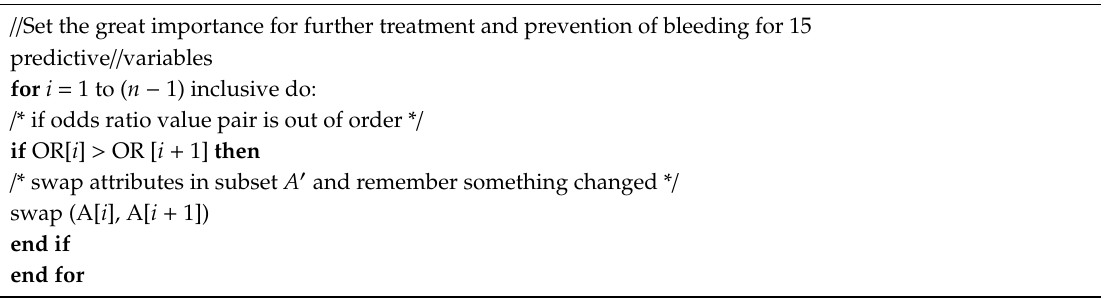
Algorithm 2: The pseudocode of the calibration process used most significant predictors of death income in cirrhotic patients